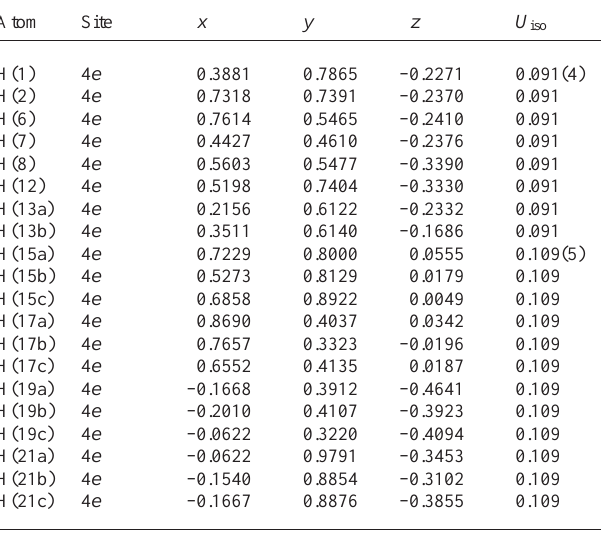
Table 2. Atomic coordinates and displacement parameters (in Å 2 )